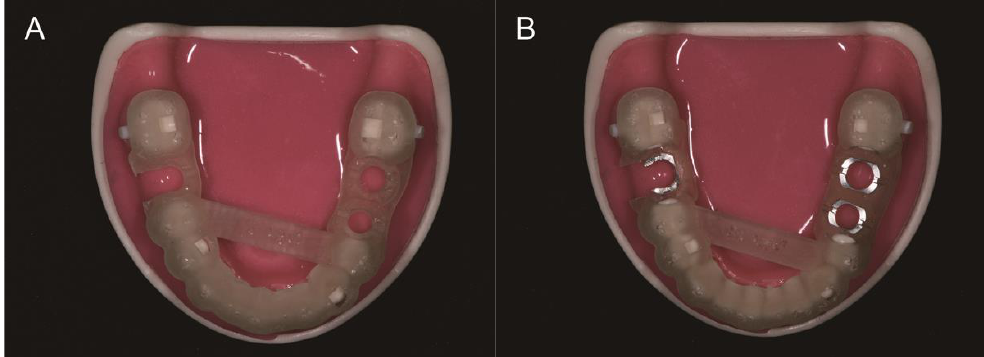
Figure 2. 3D-printed computer-assisted implant surgical guides fabricated with a 3D printer (NextDent 5100, 3D Systems, Rock Hill, SC, USA) and a resin material (NextDent SG, 3D Systems). ( A ) Metal sleeve-free surgical guide (MSF group). ( B ) Metal sleeve-incorporated surgical guide (MSI group).